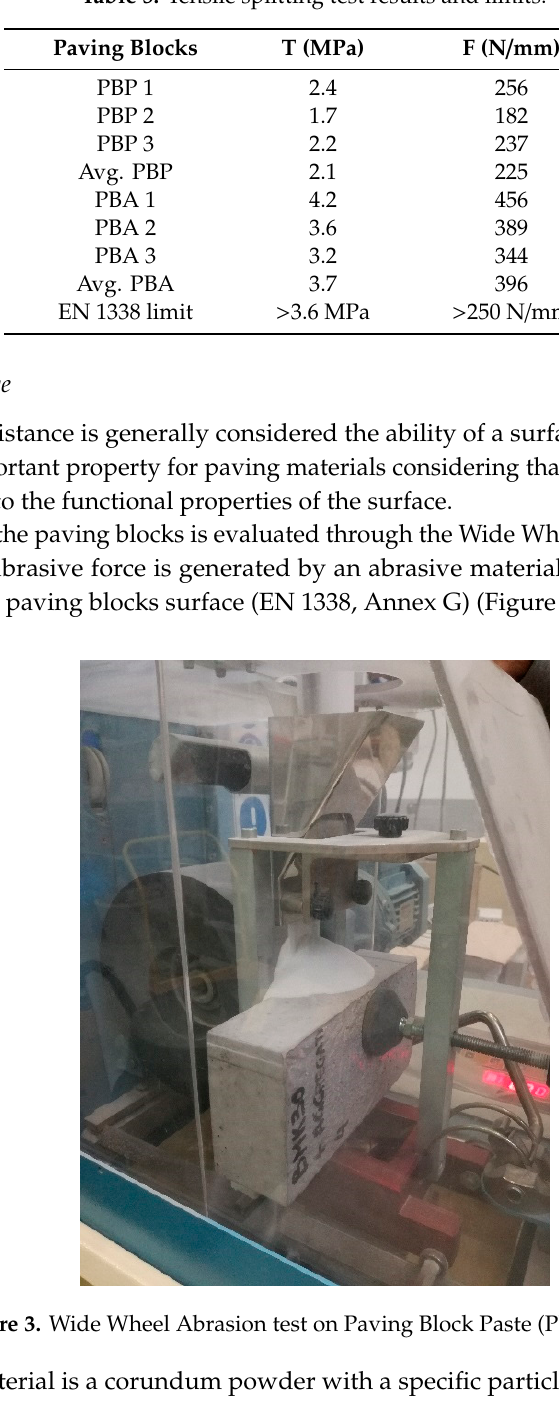
Table 6. Abrasion tests results and classification according to the EN 1338 standard.